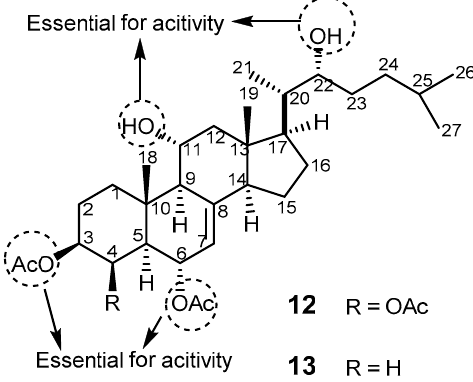
Figure 3. Structure of agosterol A ( 12 ) and 4-deacetoxyagosterol A ( 13 ). Dashed circles indicate the groups essential for reversing MDR activity.